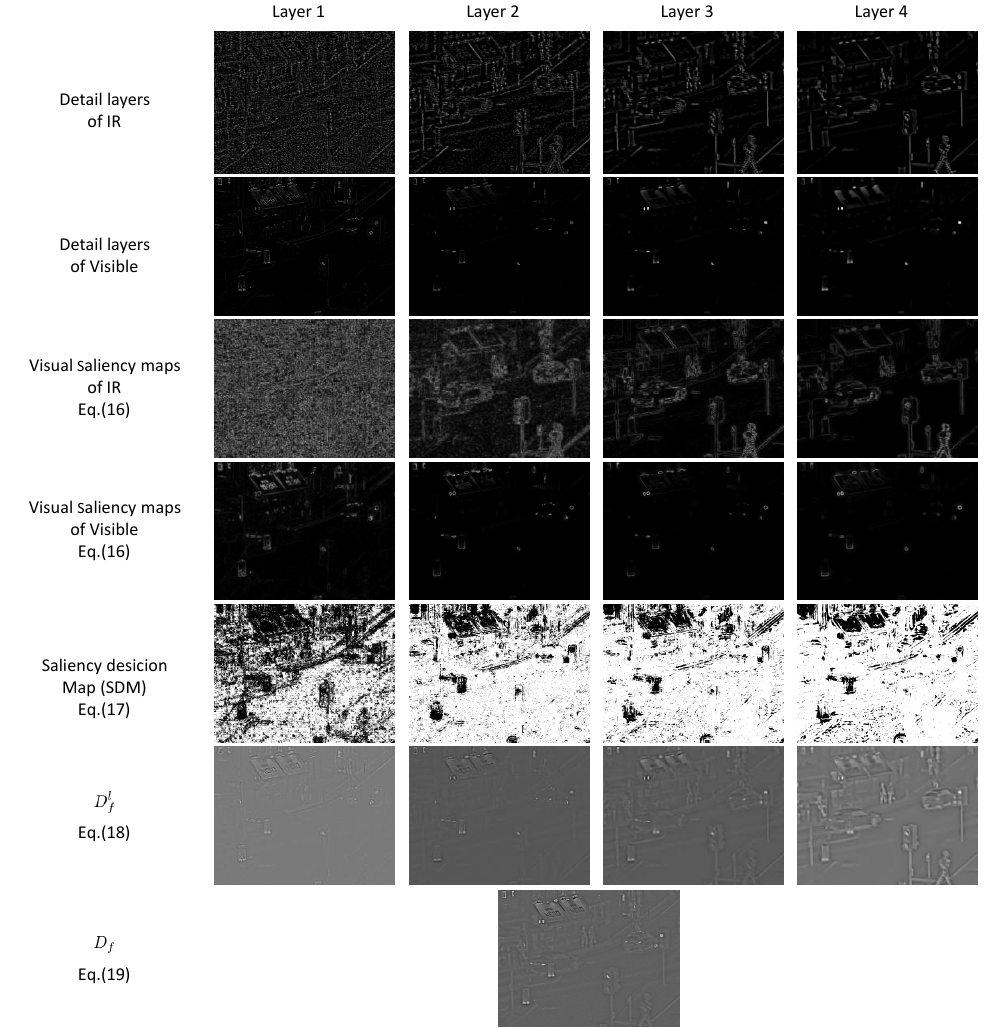
Figure 3. Four-level detail layers fusion process using visual